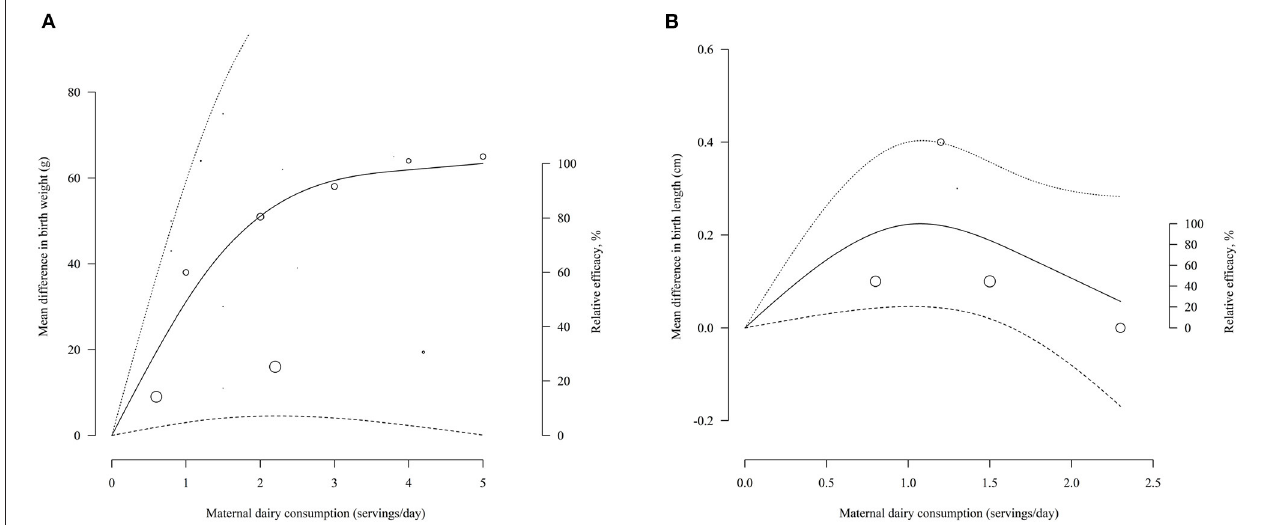
FIGURE 2 | Pooled dose-response curves for mean change in birth-weight (A) , birth-length (B) with maternal dairy consumption. Dashed lines represent the 95% confidence intervals. Circles indicate observed mean differences in individual studies, and the size of circles is proportional to the precision of the mean differences. The right axis represents the percentage of the maximum predicted